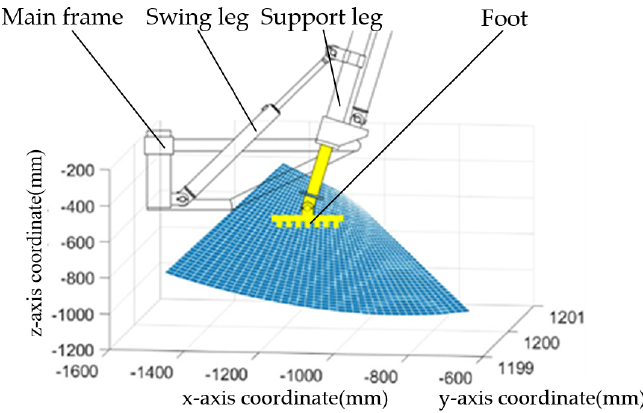
Figure 4. The trajectory and range of a single leg.